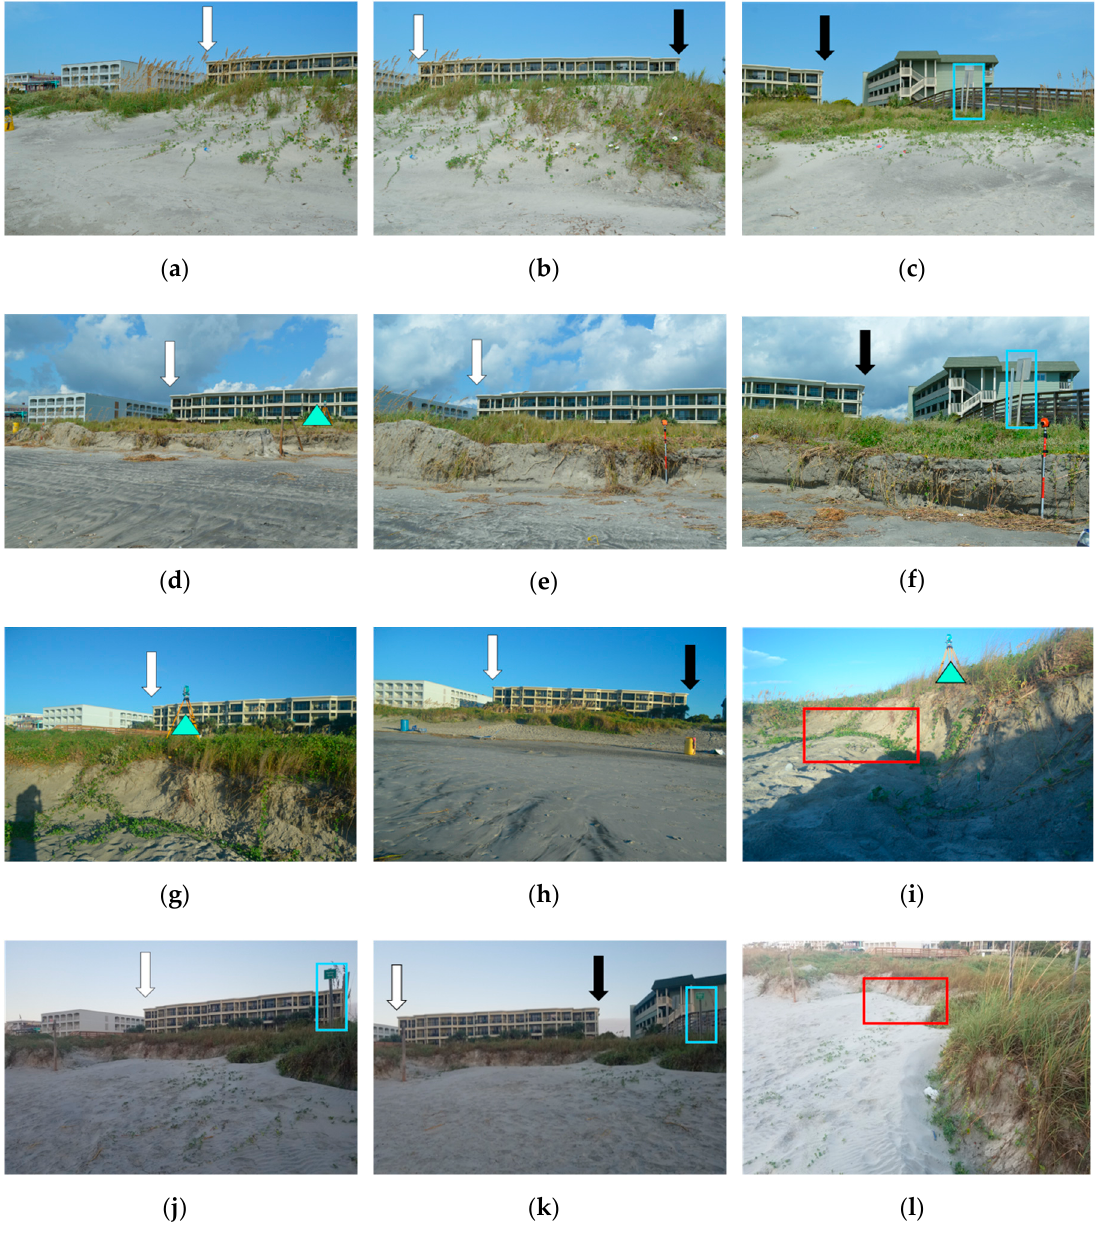
Figure 5. Site A field photographs showing conditions ( a – c ) pre- Irma , ( d – f ) post- Irma , ( g – i ) pre- Florence , and ( j – l ) post- Florence . Symbology denotes anthropogenic or natural locations that are consistent to more than one photograph.